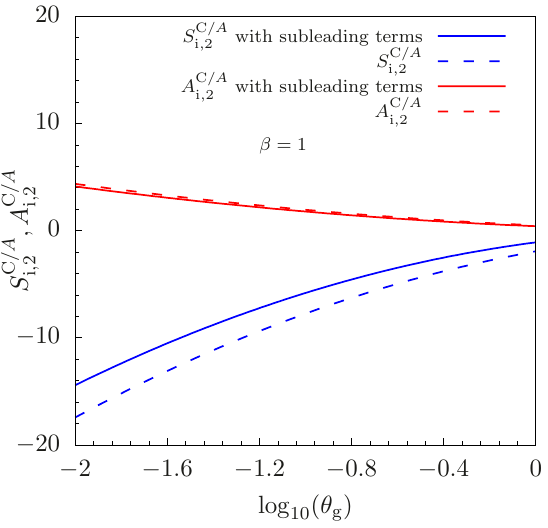
Figure 2 . Comparison of the numerical size of the NGLs (blue) and the clustering logarithms (red) at NNLO with (solid) and without (dashed) subleading contributions as a function of (cid:18) g . The results are normalized to ( (cid:11) s =(cid:25) ) 2 C i C A and ( (cid:11) s =(cid:25) ) 2 C 2 for the NGLs and the clustering logarithms, i respectively. We choose the parameters z cut = 0 : 1, (cid:12) = 1 as a representative